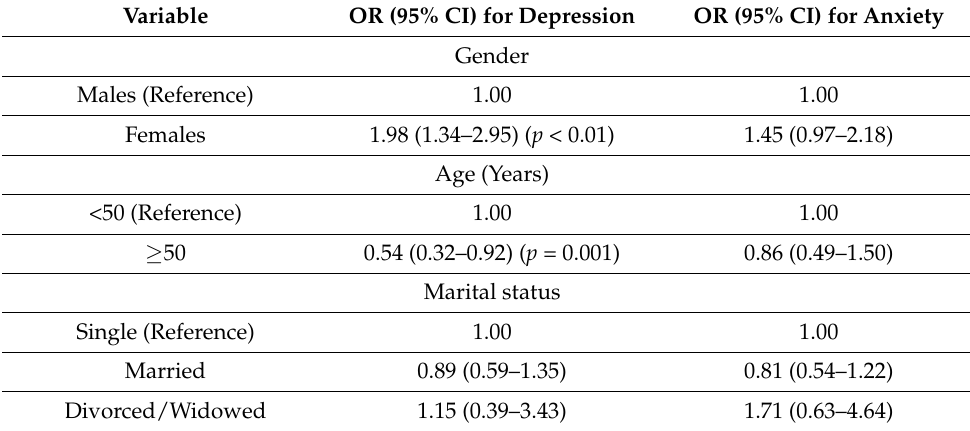
Table 4. Logistic regression analysis for healthcare professionals